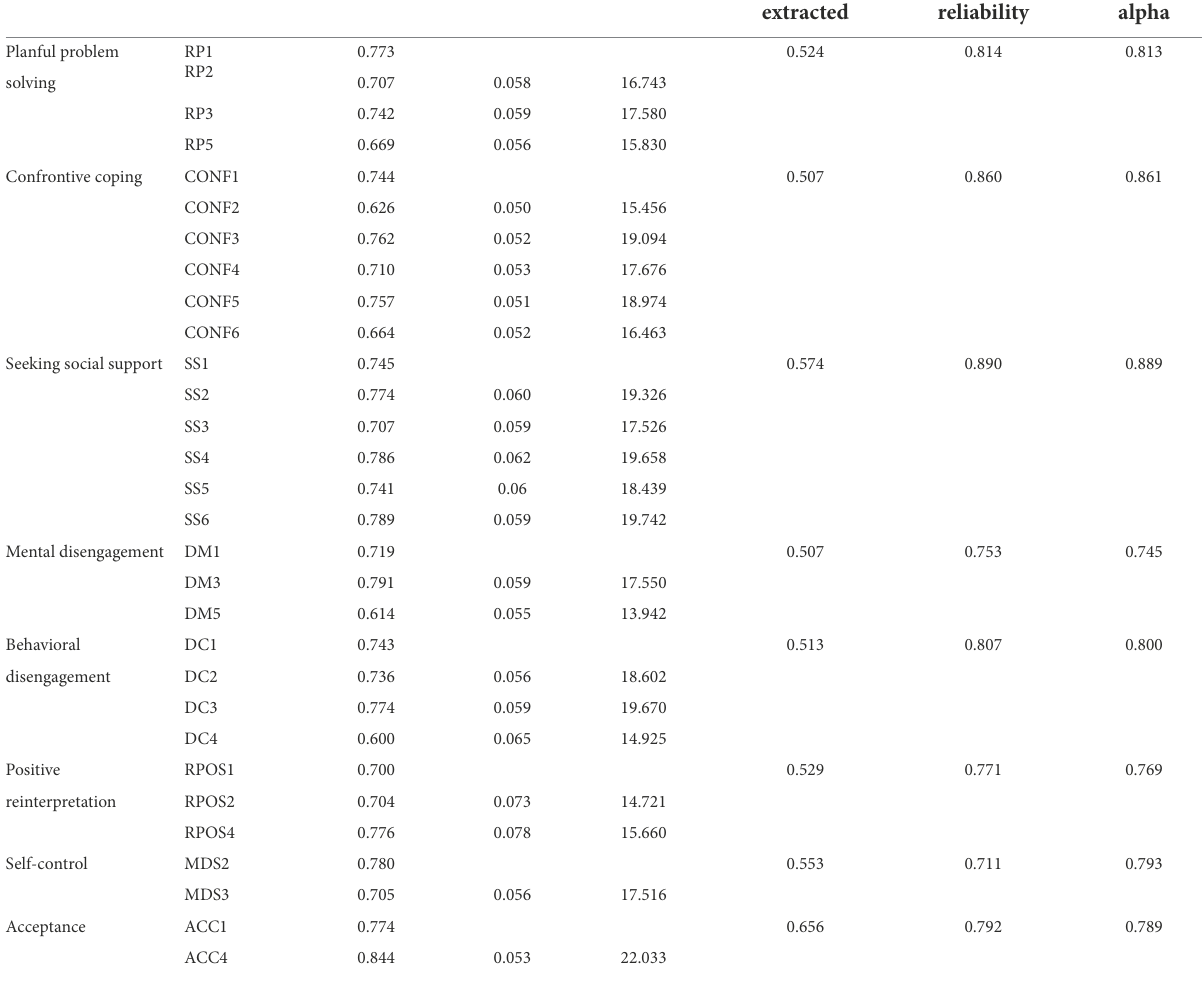
TABLE 3 Measurement model. Std. Estimate Std. Error Critical ratio Average variance